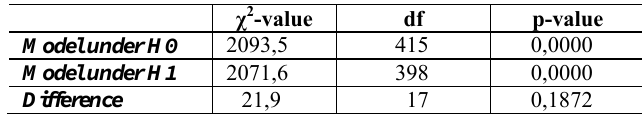
Table 6: Factor loading cross-validation: Chi-square difference test results